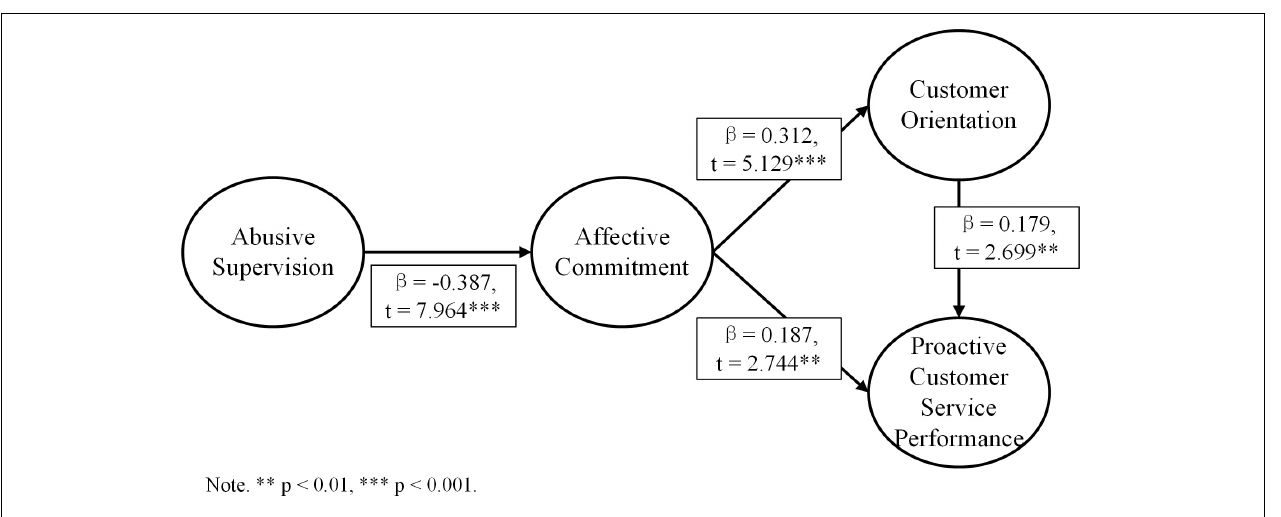
FIGURE 2 | Final research